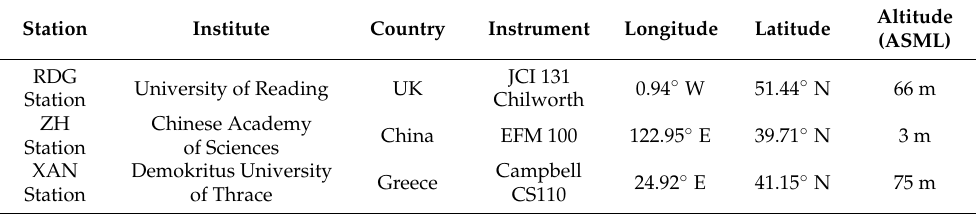
Figure 1. Map of the global locations of the RDG station, the XAN station, and the ZH station (the three red stars indicate the stations.). Table 1. Basic information and locations of the instruments at the three stations.